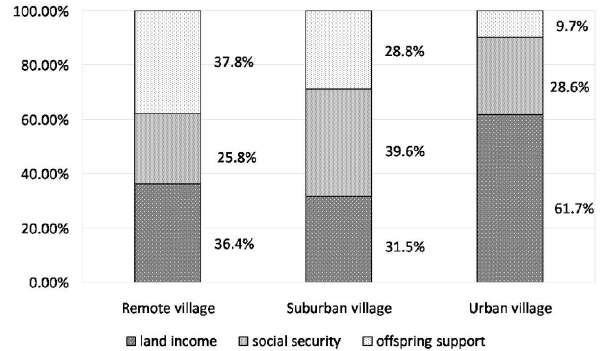
Figure 4. Proportion of income sources of the elderly in rural villages.